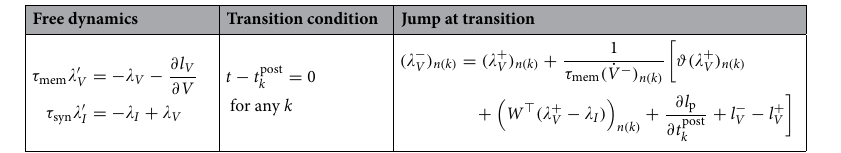
Table 2. The adjoint spiking network to Table 1 that computes the adjoint variable (cid:31) I needed for the gradient [Eq. (2)]. The adjoint variables are computed in reverse time (i.e., from t = T to t = 0 ) with ′ = − d d t denoting − t post the reverse time derivative. ( (cid:31) V ) n ( k ) experiences jumps at the spikes times k , where n ( k ) is the index of the neuron that caused the k th spike. Computing this system amounts to the backpropagation of errors in time. − (cid:31) + The initial conditions are (cid:31) V ( T ) = (cid:31) I ( T ) = 0 and we provide (cid:31) V in terms of V because the computation happens in reverse